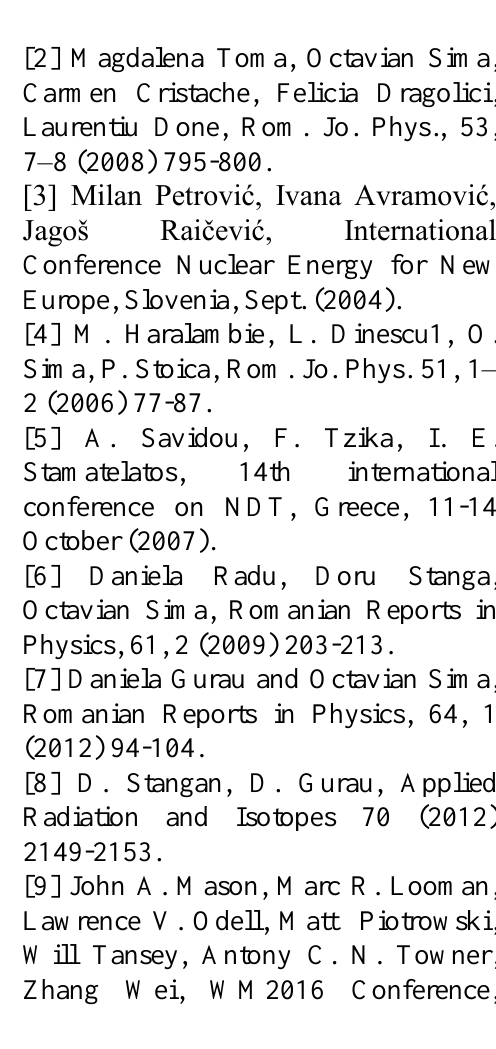
Fig.7: The average efficiency curve of spectrum energy of 152 Eu relative to whole volume of drum in polynomial fitting of order